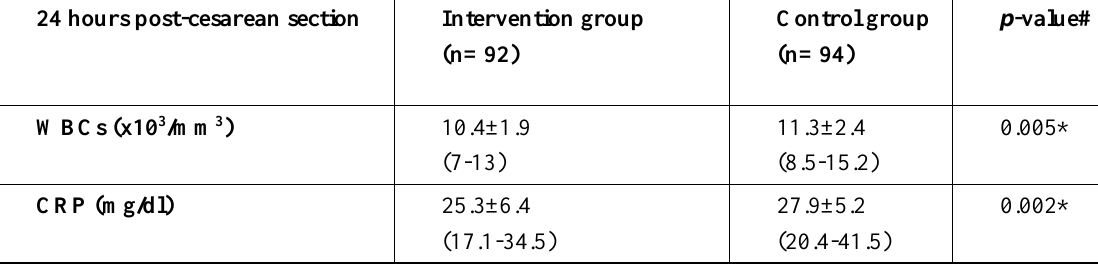
Table 3: Post-CS WBCs and CRP among the studied groups. 24 hours post-cesarean